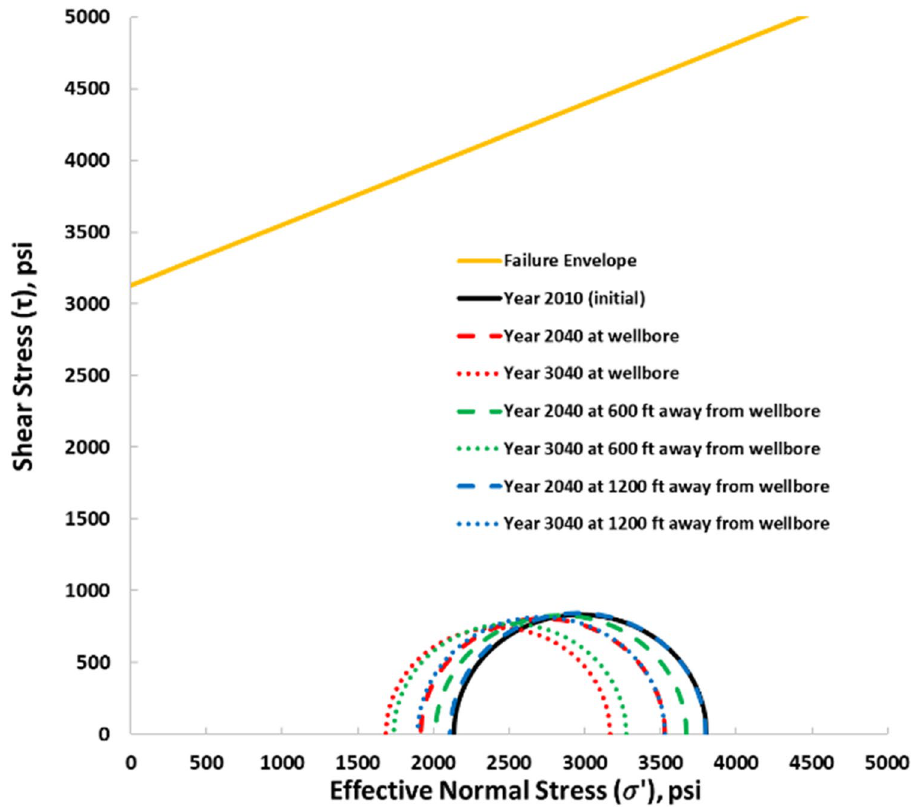
Figure 17. Mohr circles depicting the stress changes within the caprock (Layer 5) when 5500 psi BHP injection pressure was